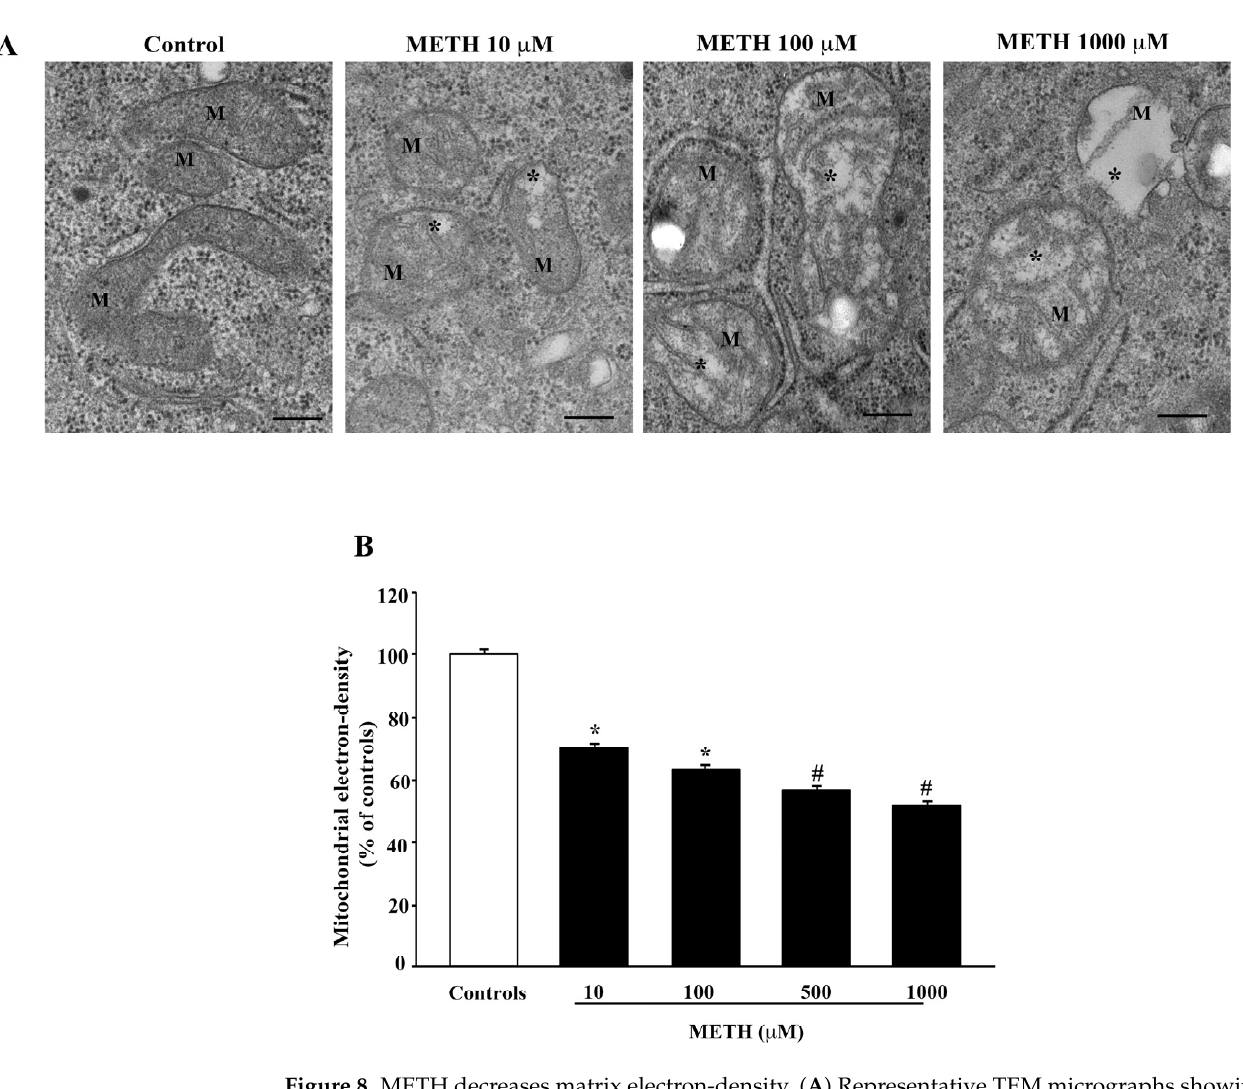
Figure 8. METH decreases matrix electron-density. ( A ) Representative TEM micrographs showing a dose-dependent decrease in electron density of mitochondrial matrix. In control, mitochondria possess a marked electron dense matrix, whereas after increasing doses of METH (from 10 µ M up to 1000 µ M) the mitochondria possess a diluted matrix that appears less electron dense compared with control (*). M = mitochondria. ( B ) Graph reports values showing matrix dilution as a weighted measurement (percentage of matrix electron density from controls). Values are given as the percentage mean ± S.E.M from N = 150 mitochondria per group. * p ≤ 0.05 compared with controls; # p ≤ 0.05 compared with controls and METH 10 µ M and 100 µ M. Scale bars = 160